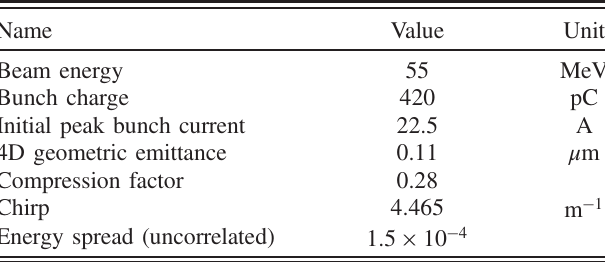
TABLE II. Initial beam parameters for JLEIC ERL magnetized beam transport.